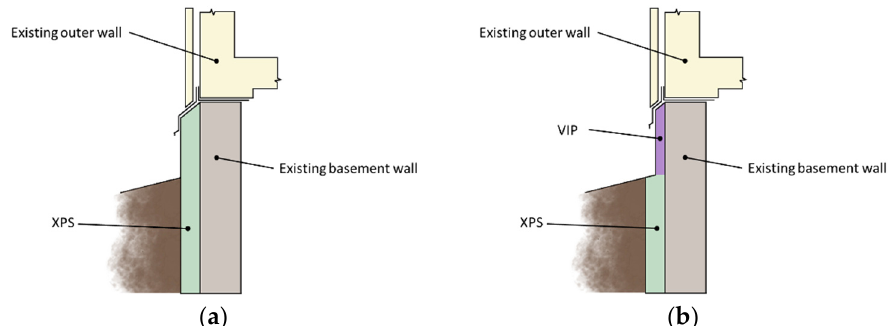
Figure 1. Basement details illustrating the difference between ( a ) ordinary insulation and ( b ) superinsulation. With the ordinary insulation, the insulation will protrude from the wall and change the look of the building.